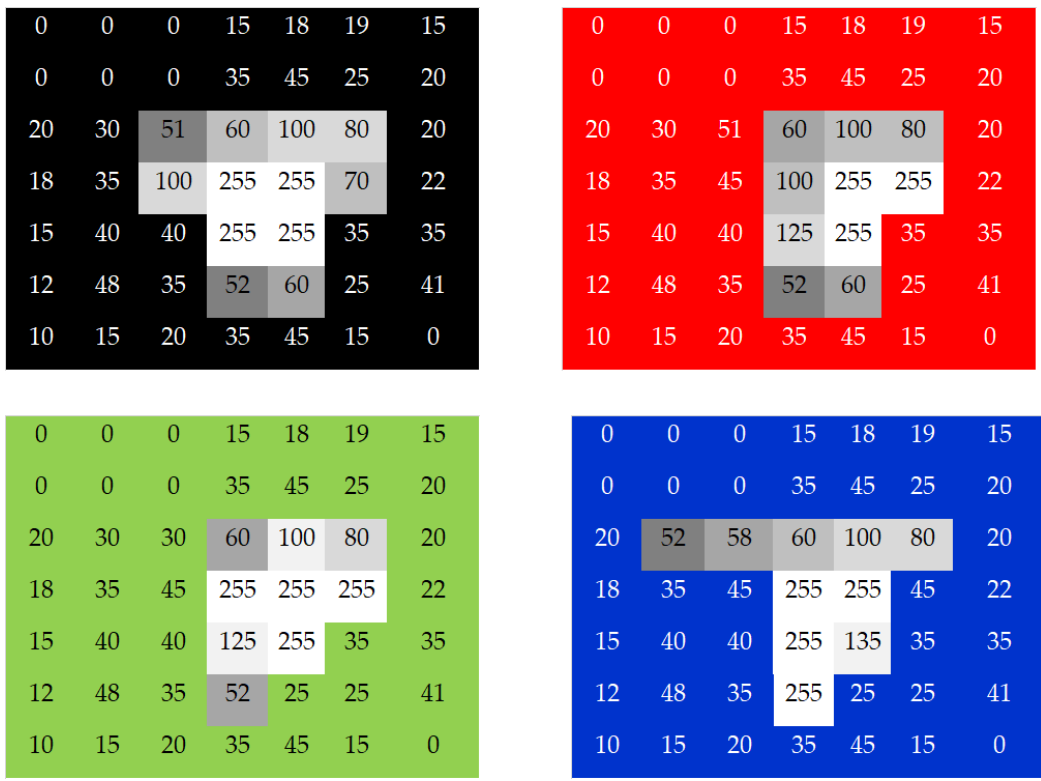
Figure 5. The golden sample coating the colored photoresists (PRs) with heights of 130, 131, 155, and 146 μm. Row ( A ) indicates the various solder balls magnified by microscope 10×, ( B ) indicates the grayscale image, and ( C ) is enlarged 1600% by Photoshop software.